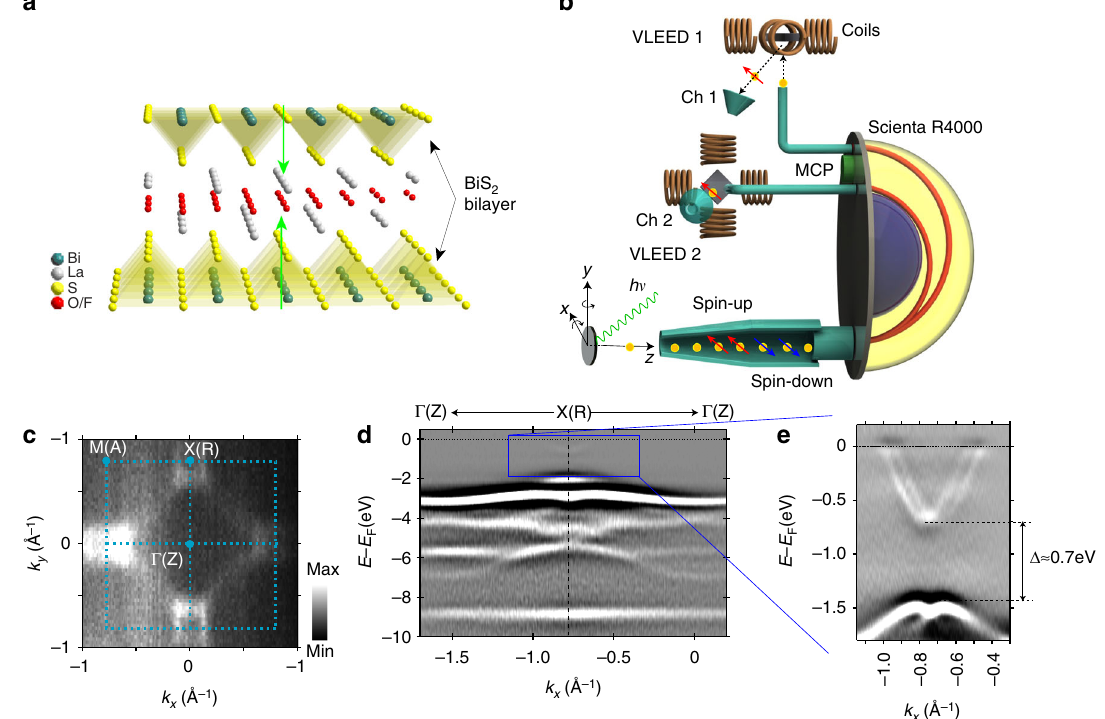
Fig. 1 Electronic structure of LaO 0.55 F 0.45 BiS 2 observed by angle-resolved photoemission (ARPES). a Crystal structure of La(O,F)BiS 2 with a buffer layer La (O,F) separating the active BiS 2 bilayer. Green arrows denote opposite local polar fi elds in BiS 2 bilayer. b Illustration of Ef fi cient SPin REsolved SpectroScOpy (ESPRESSO) machine at HiSOR and the experimental geometries for the ARPES and spin-ARPES measurements. c Constant energy contour (CEC) at E B = 0.2 eV. d Band structure ( E – k map) along Γ (Z)-X(R) obtained by ARPES measurement taken with h ν = 70 eV and T S = 50 K. The CEC map is integrated over a window of ± 20 meV and the E – k map is obtained by the second derivative of energy distribution curves (EDCs) of original ARPES data. e Bands in the range of 0 – 1.8 eV below Fermi level (the boxed area of d ) are clearly seen in the ARPES data taken with h ν = 18 eV and T S = 50